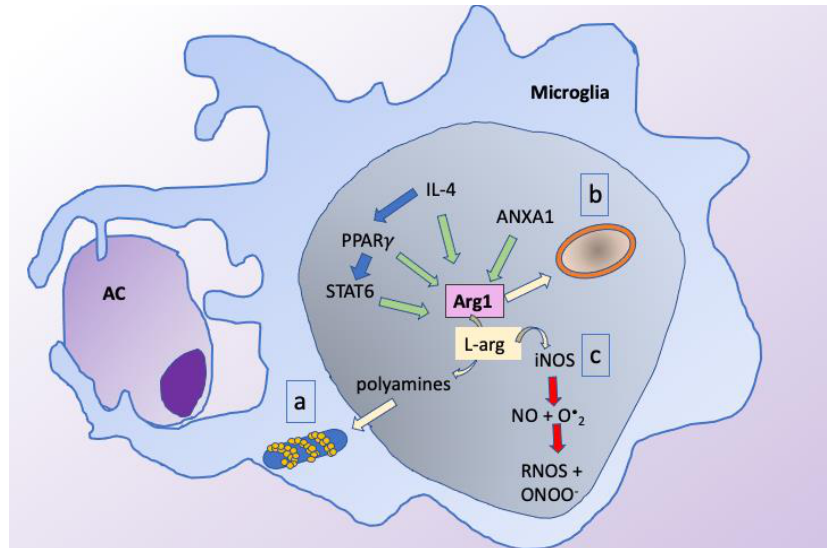
Figure 2. Different roles of Arg1 in efferocytosis: Arg1 is a downstream target of multiple regulators of efferocytosis. Arg1 is involved in engulfment by regulation of phagolysosome formation ( a ) in lysosomal digestion ( b ) and exhibits anti-inflammatory effects by reducing NO radical formation ( c ).